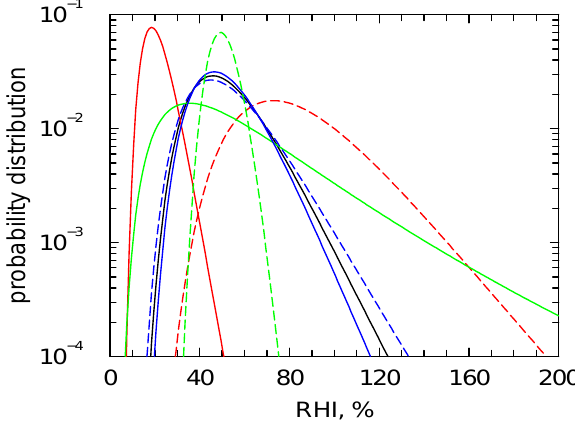
Fig. 2. Probability distributions of RHI obtained with normal dis- tributions of T . The black curve is equal to the baseline case shown as the blue curve in Fig. 1. Red, green, and blue curves are obtained by varying RHI o , σ , and T o , respectively. See text for